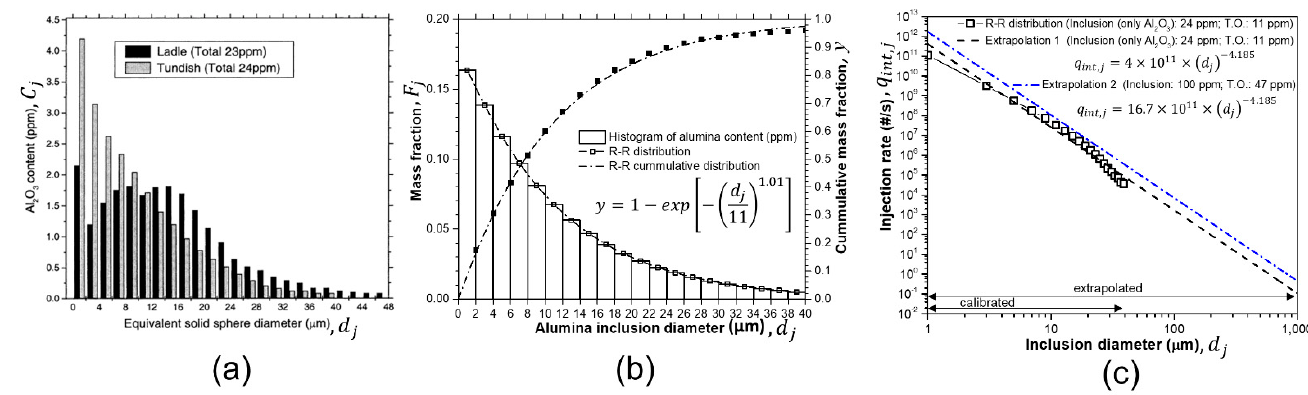
Figure 4. Injected distribution of inclusions: ( a ) measured in tundish [32], ( b ) transformed Rosin-Rammler size distribution of the tundish, and ( c ) injection rate into the nozzle.